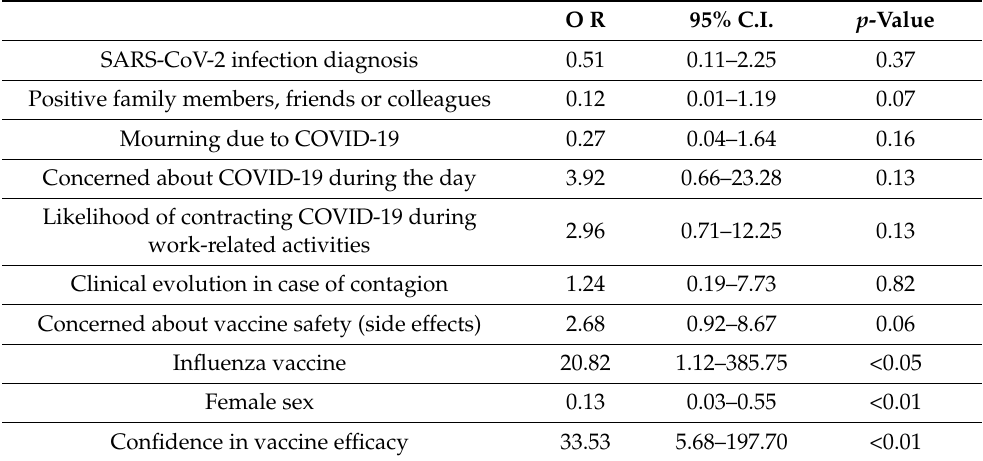
Table 2. Factors influencing participant vaccine intention (logistic regression